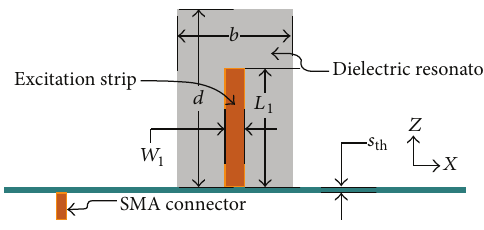
Figure 2: Proposed DRA structure ( 𝑋𝑍 plane).